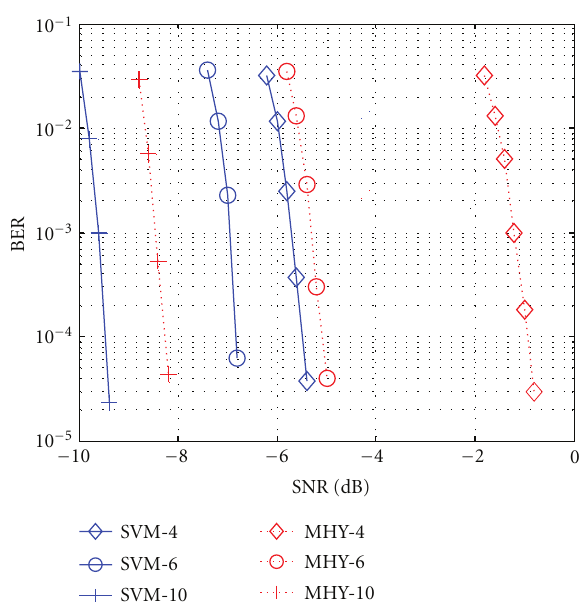
Figure 10: BER performance comparisons of the SVM with MHY method at the output of the LDPC decoder with di ff erent sampling rates. Using SVM-4, SVM-6, and SVM-10 for the SVM method (solid lines) and MHY-4, MHY-6, and MHY-10 for the MHY method (dashed lines) with f s = 4 f c , f s = 6 f c , and f s = 10 f c ,